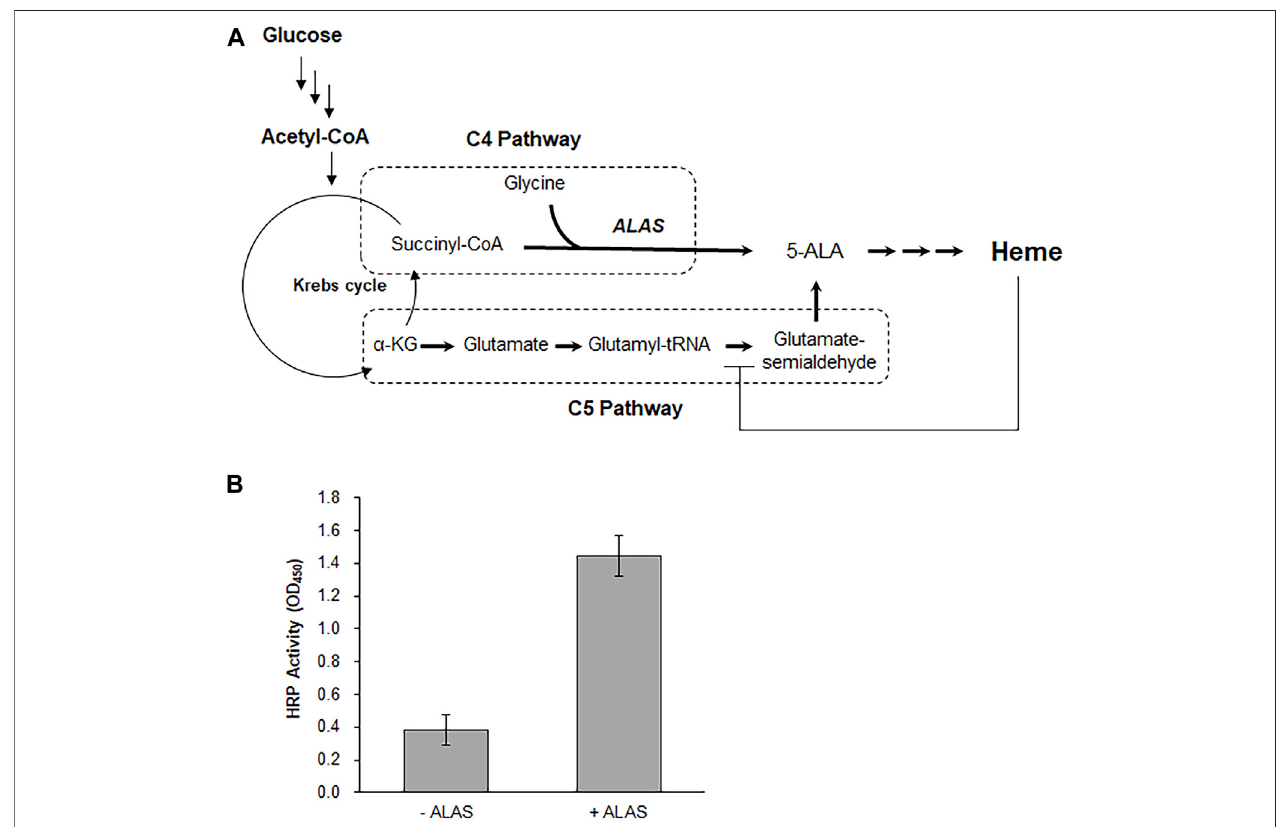
FIGURE 4 | Co-synthesis of heme and apo-HRP. (A) To activate the C4 pathway for the synthesis of heme from glucose, the reaction mixture was supplemented with puri fi ed ALAS from R. capsulatus . (B) Effect of ALAS addition on the enzyme activity of cell-free synthesized HRP.